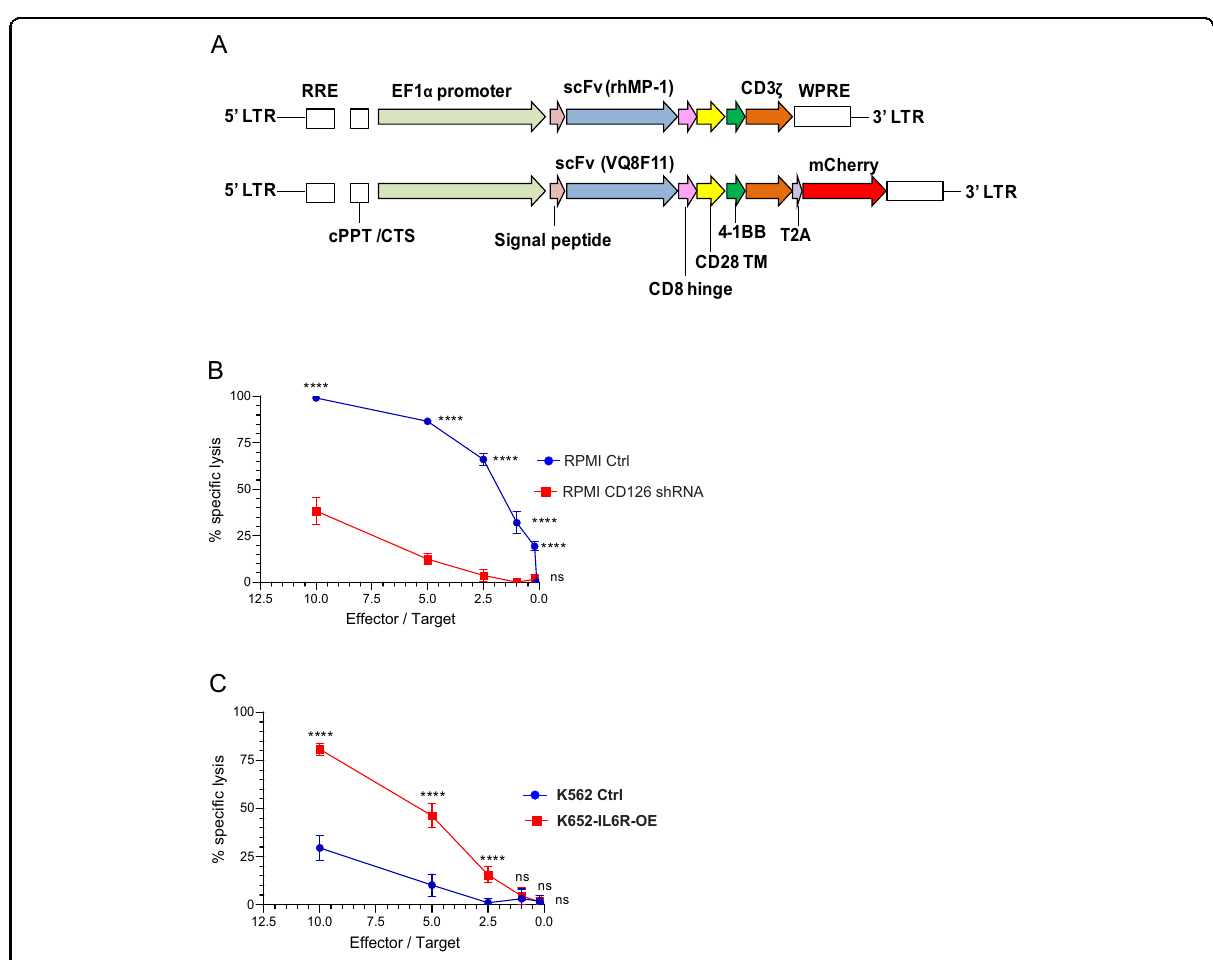
Fig. 2 Development of a CD126-targeted CAR. a Schematic representation of CAR constructs used in this study. b CAR-T cell-mediated killing of RPMI and a derivative population with suppressed CD126 expression using shRNA (RPMI-CD126 shRNA) both expressing luciferase incubated with CAR-T cells at different effector-to-target ratios ( n = 12). c Cell killing of K562 and K562 that express CD126 (K562 CD126 OE) and luciferase with CAR-T cells at different effector-to-target ratios ( n = 12). Data are mean ± standard deviation. Two-way ANOVA and multiple comparison test. n.s. Not signi fi cant. **** P <